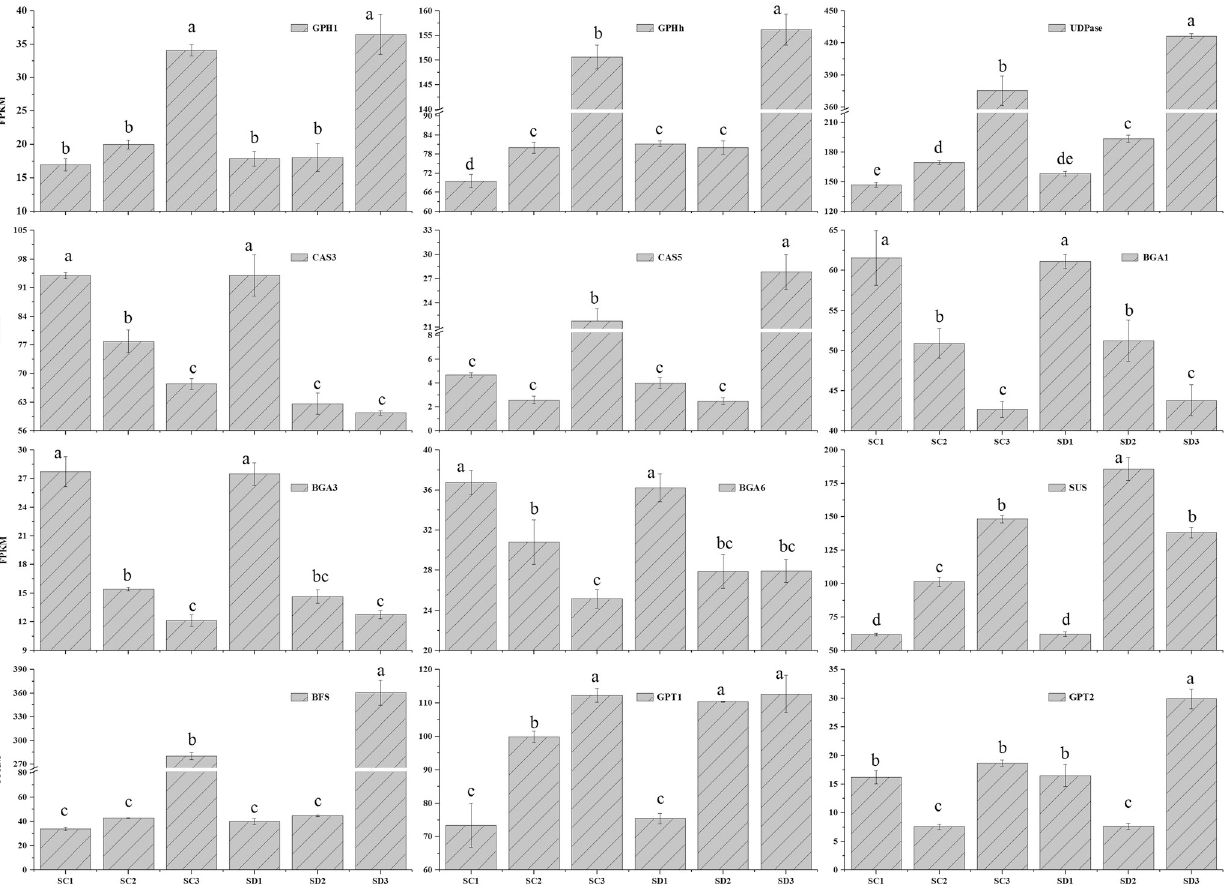
Fig 9. Expression analyses of genes related to starch breakdown, sucrose synthesis and transportation. The x-axis indicates the different stages. The y- axis shows the expression values of the FPKMs. All values were repeated three times and the data are presented as the mean ± SD. Different letters indicate significant differences at P < 0.01. GPHl: CU_locus25159; GPHh: CU_locus35718; UDPase: CU_locus18418; CAS3: CU_locus34862; CAS5: CU_locus29673; BGA1: CU_locus24690; BGA3: CU_locus7299; BGA6: CU_locus43; SUS: CU_locus46184; BFS: Glucosucrase, CU_locus32011; GPT1: CU_locus27685; GPT2: